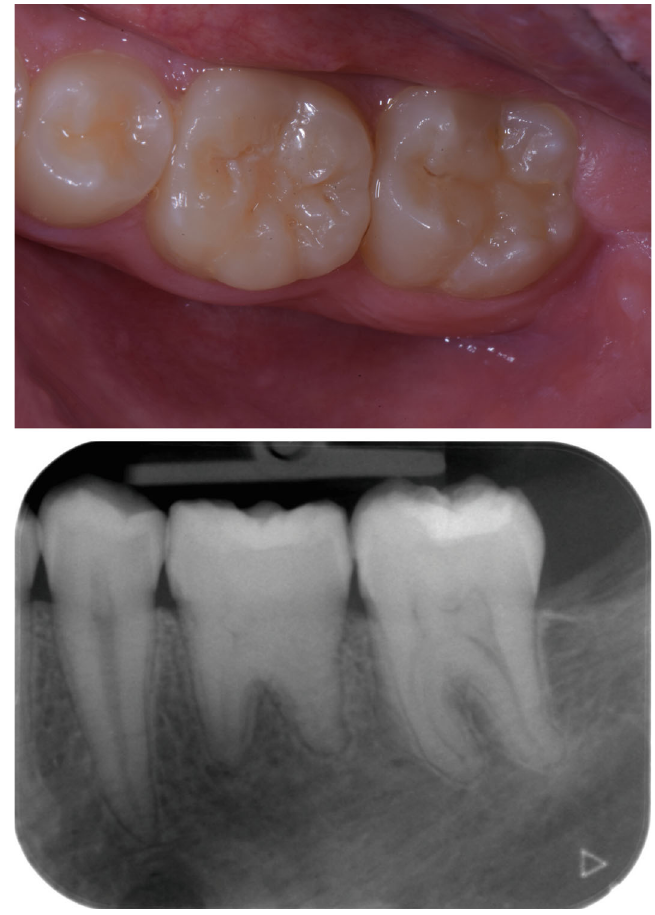
Figure 6: Tooth 36 at 2 years of